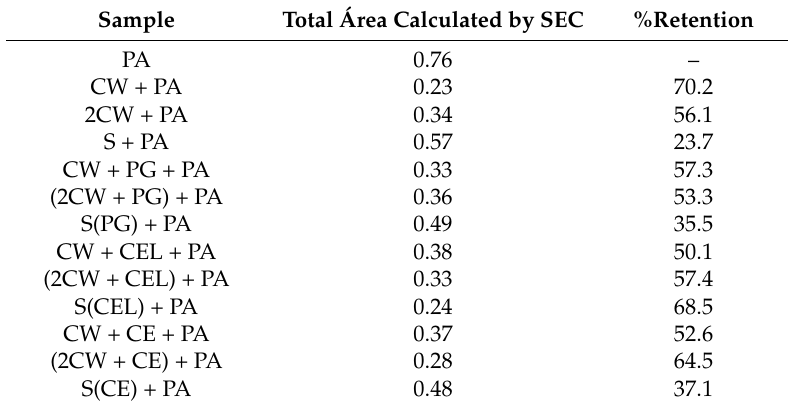
Table 4. Total area observed in the size exclusion chromatography analysis for the original PAs and those remaining in solution after the interaction and the percentage of retention